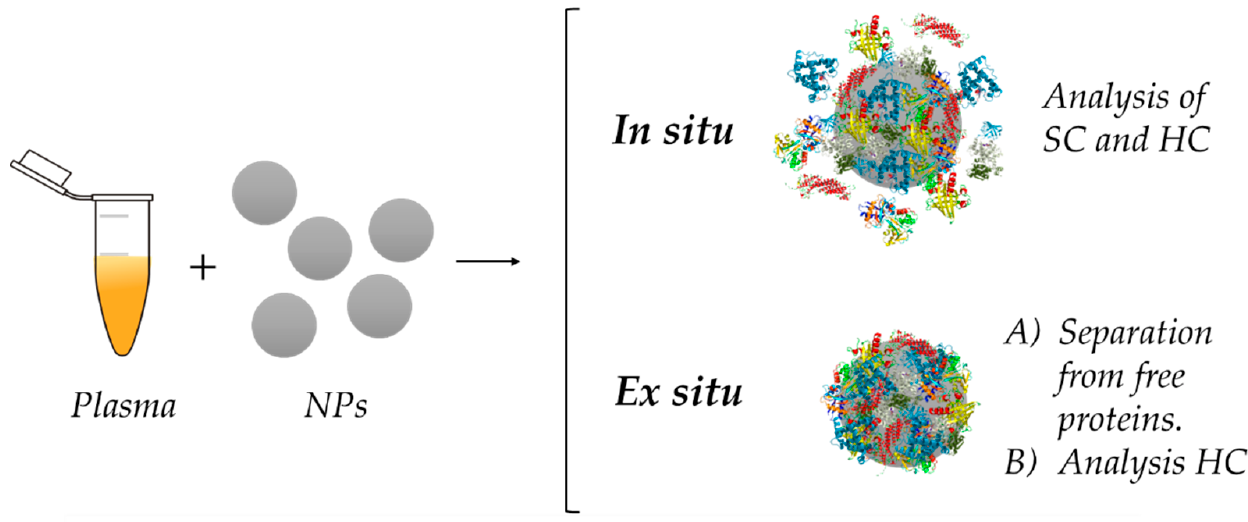
Figure 8. Schematic comparison of the in situ and ex situ approaches for PC investigations. NPs are incubated in plasma containing proteins, leading to formation of the corona. While ex situ analysis performs a purification step prior to analysis, in situ measurements are carried out in protein media without separation, which allows the study of both HC and SC.